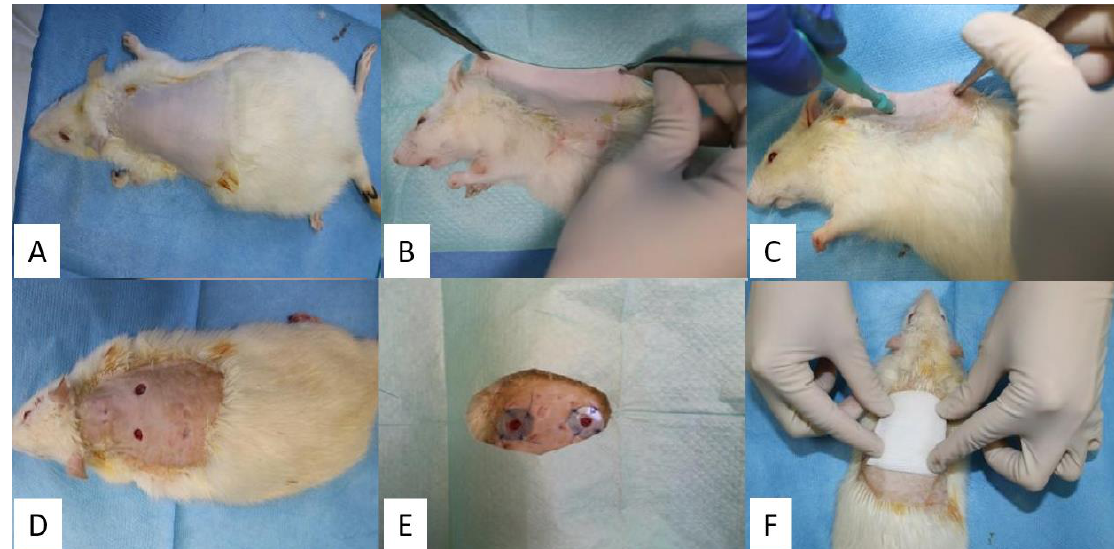
Figure 13. Obtaining the two cutaneous excisions and application of silicate rings and the ointment: antiseptic area ( A ), lateral positioning ( B ), using the biopsy-punch for excision formation ( C ), opening the fold to obtain two excisions ( D ), suture of silicate rings ( E ) application of a sterile pad ( F